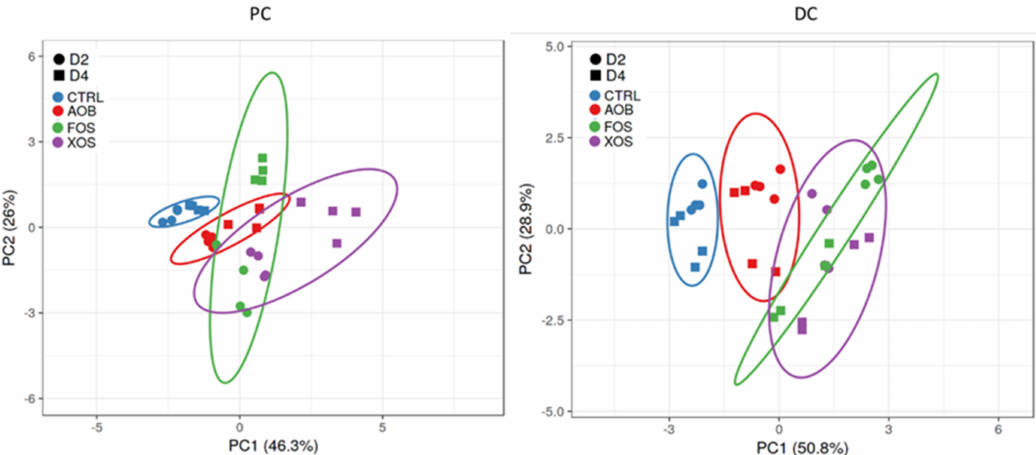
Figure 3. Principle component analysis plots for ( left ) PC and ( right ) DC long-term SHIME samples, representing metabolic data (acetate, propionate, butyrate, BCFA, total SCFA and lactate) obtained on four different time points (days 3/4/10/11 of treatment) for blank control, AOB, XOS and FOS for two donors (D2 and D4). Ellipses indicate a confidence interval of 95%. PC = proximal colon; DC = distal colon; CTRL = control; AOB = antioxidant blend; XOS = xylooligosaccharides; FOS = fructooligosaccharides; D = donor; BCFA = branched-chain fatty acids; SCFA = short-chain fatty